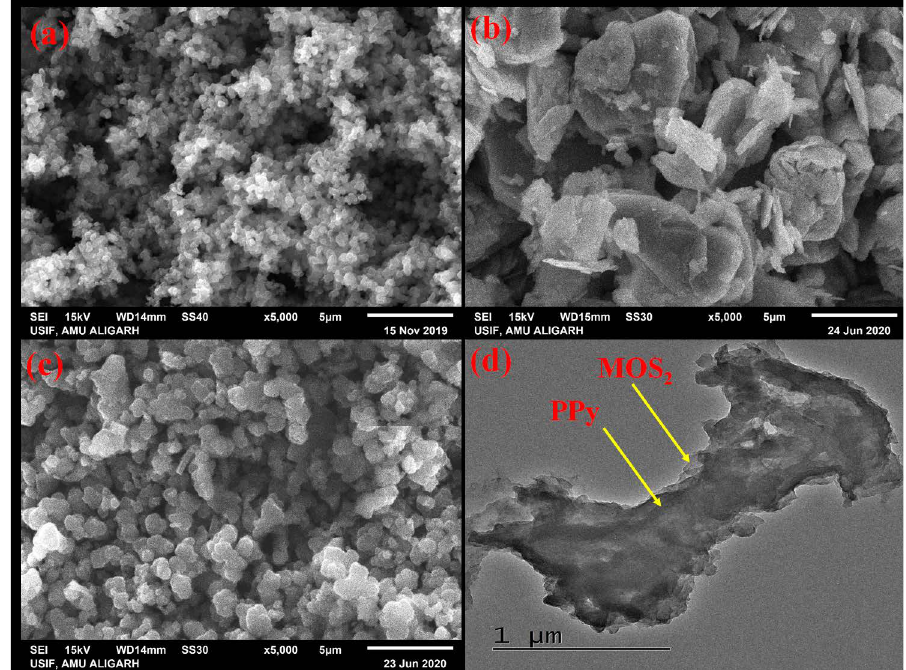
Figure 3. Scanning electron microscopy (SEM) micrographs of: ( a ) PPy, ( b ) MoS 2 ( c ) PPy / MoS 2 and ( d ) transmission electron microscopy (TEM) micrograph of PPy / MoS 2 .